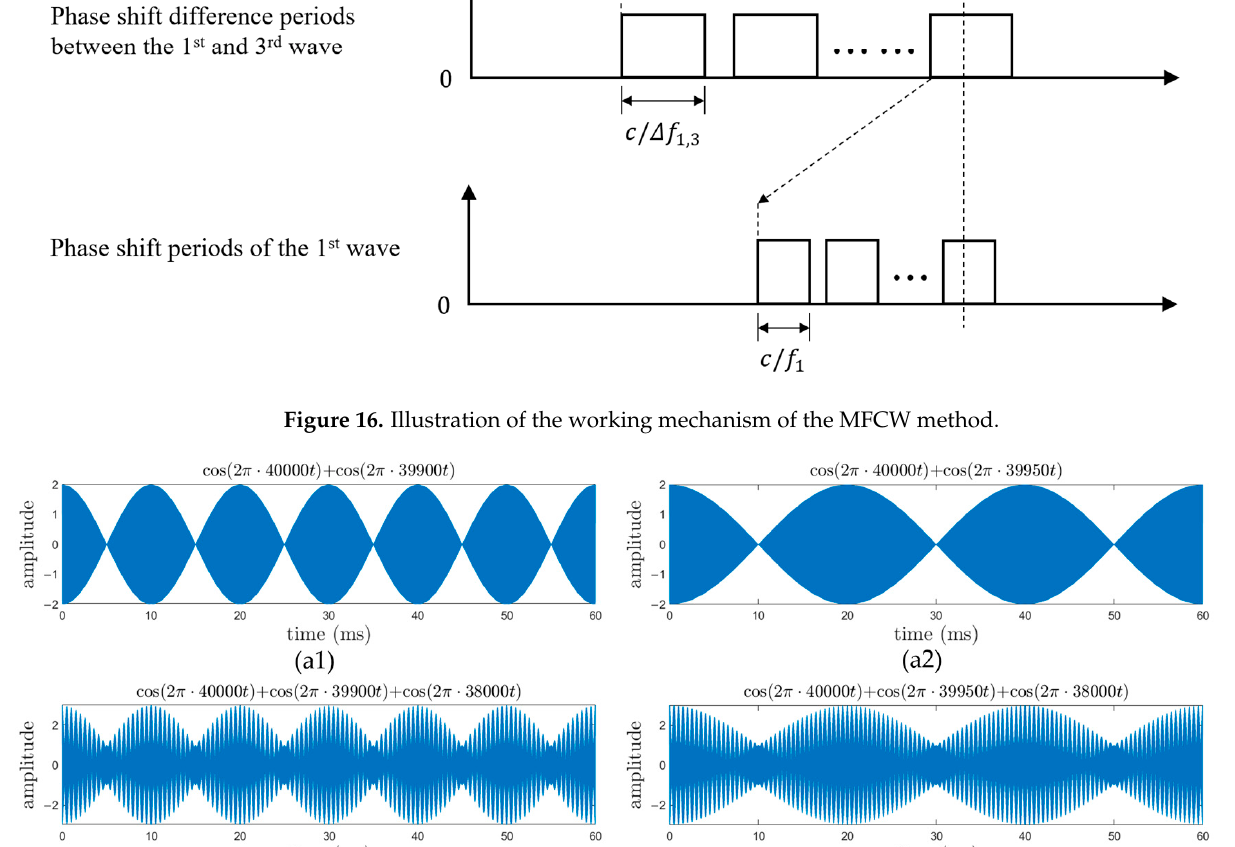
Figure 16. Illustration of the working mechanism of the MFCW method.